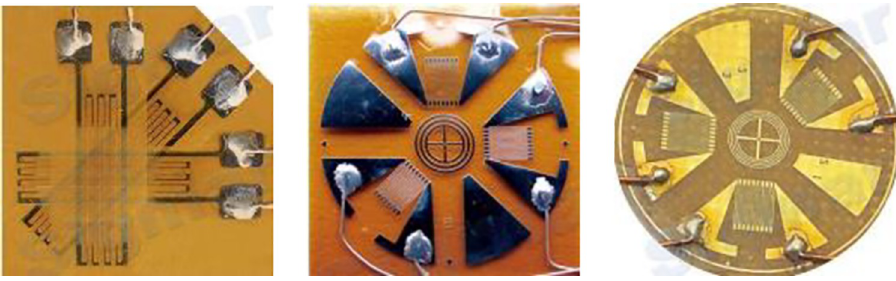
Fig 3. Plane strain expressed by three line strains.